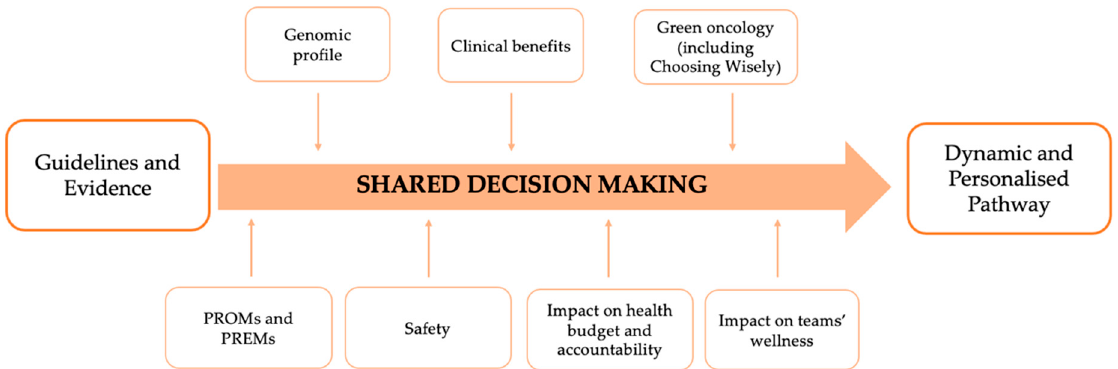
Figure 3. The personalized pathway on breast cancer.